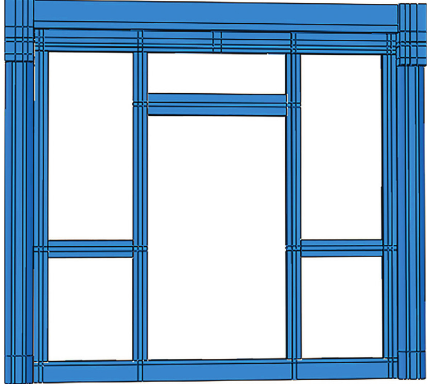
Figure 13: Unreinforced wooden door frame wjg.